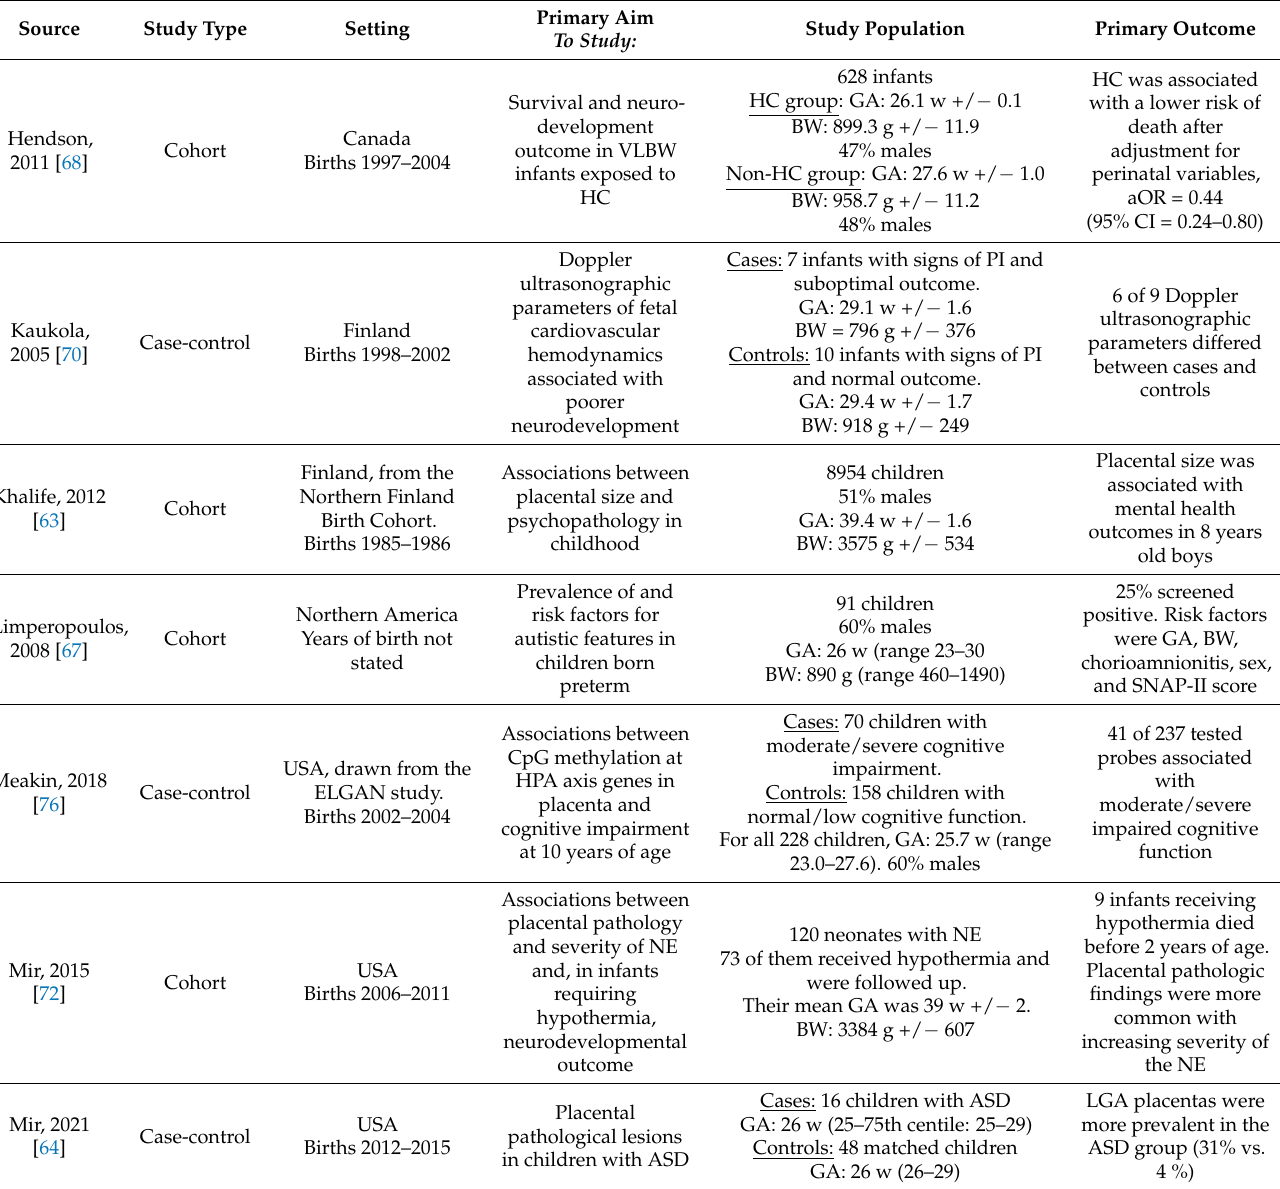
Table 1. Characteristics of the included